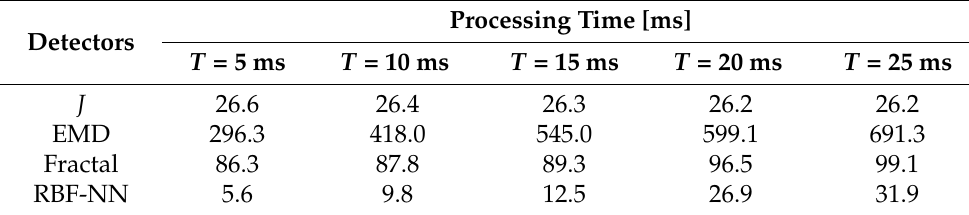
Table 5. Processing time of each detector in various T